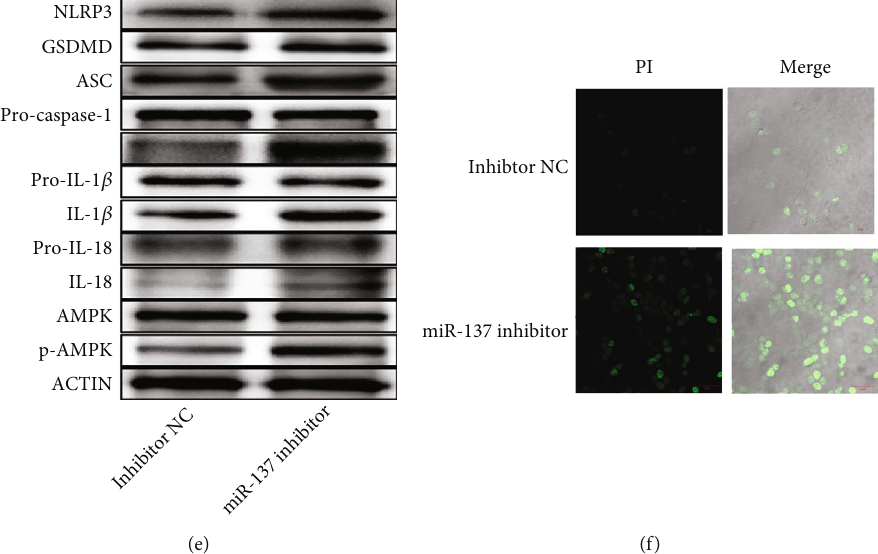
Figure 2: miR-137 regulates AMPK and induces pyroptosis. (a) Impact of miR-137 mimic transfection on AMPK mRNA expression. (b) Impact of miR-137 mimic transfection on in fl ammation and pyroptosis-related proteins. (c) Impact of miR-137 mimic transfection on cell pyroptosis; (d) AMPK mRNA expression after miR-137 inhibitor transfection. (e) Related protein expression after miR-137 inhibitor transfection. (f) Impact of miR-137 inhibitor transfection on cell pyroptosis. Each test ran in triplicates. The means were pairwisely compared using Student ’ s t -test. P < 0 : 01 means the presence of statistical signi fi cance.